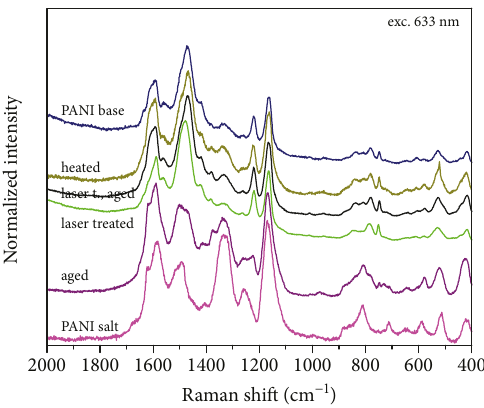
Figure 7: Comparison of degradation methods on a PANI-S fi lm on gold. Raman spectra are obtained with the 633nm excitation